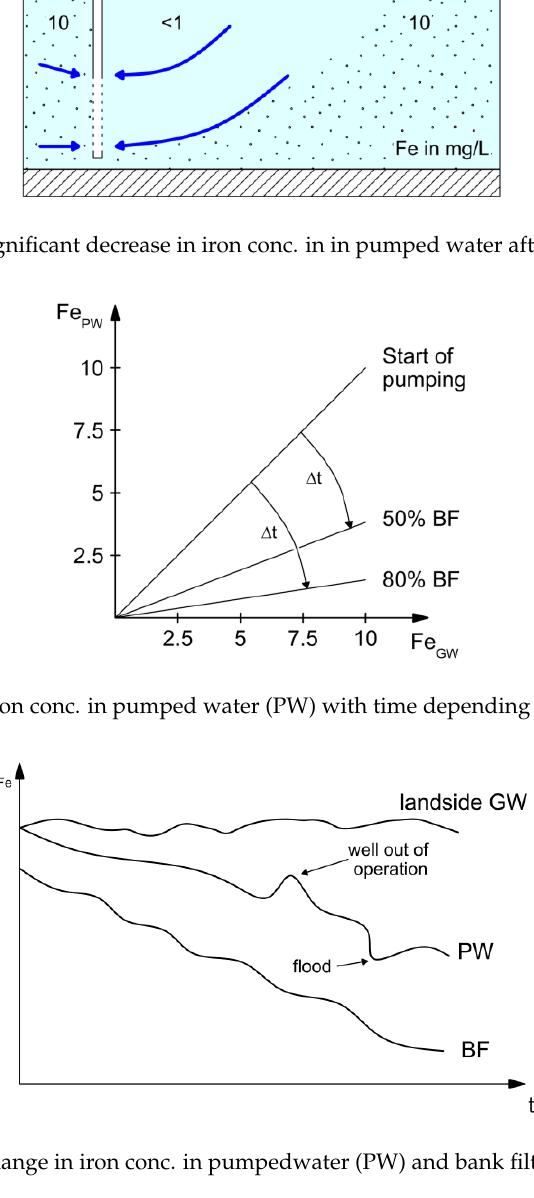
Figure 7. Expected change in iron conc. in pumpedwater (PW) and bank filtrate (BF) for Case B.